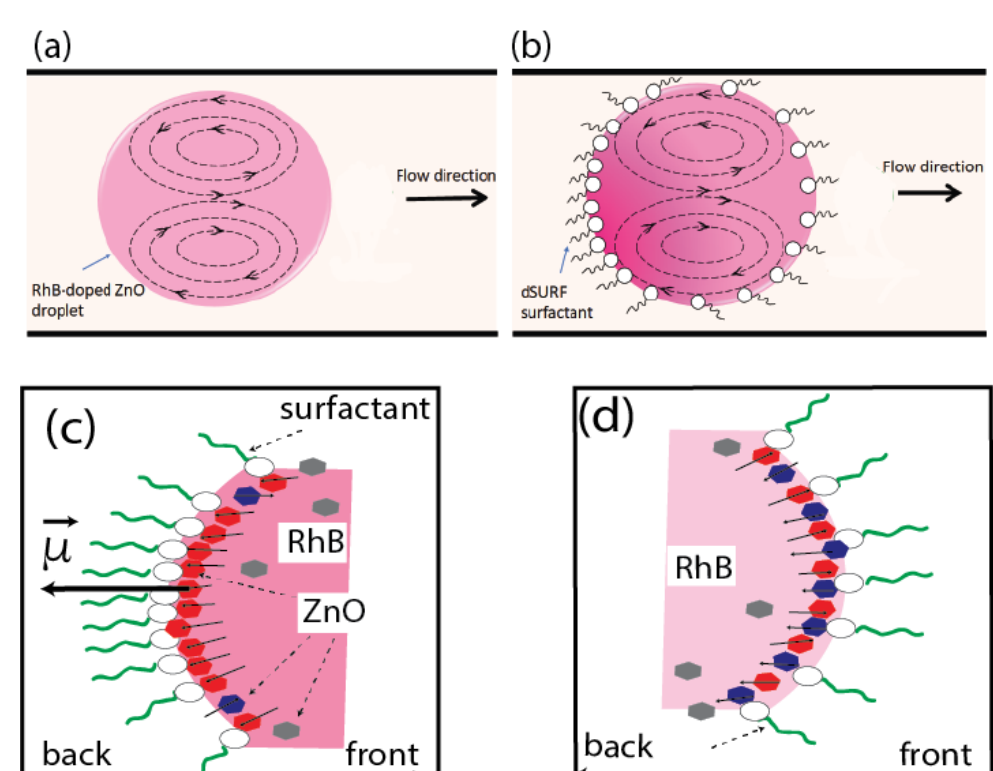
Figure 13. Schematic illustration of tip-streaming effect in droplet carried by oil flow: ( a ) without surfactant and in the presence of surfactant ( b ); ( c , d ): illustration of non-homogeneous distribution of ZnO NPs in the back area ( c ) and the front area ( d ) of the droplet; red hexagons represent ZnO NPs with their electric dipoles oriented outwards and blue ones represent those with electric dipoles oriented